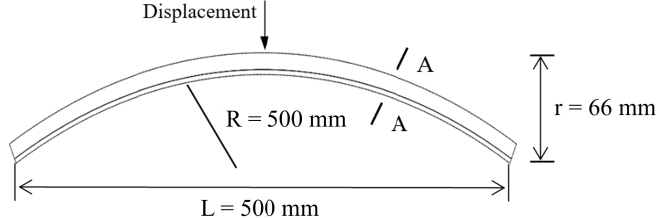
Table 2. Material parameters of FRP.